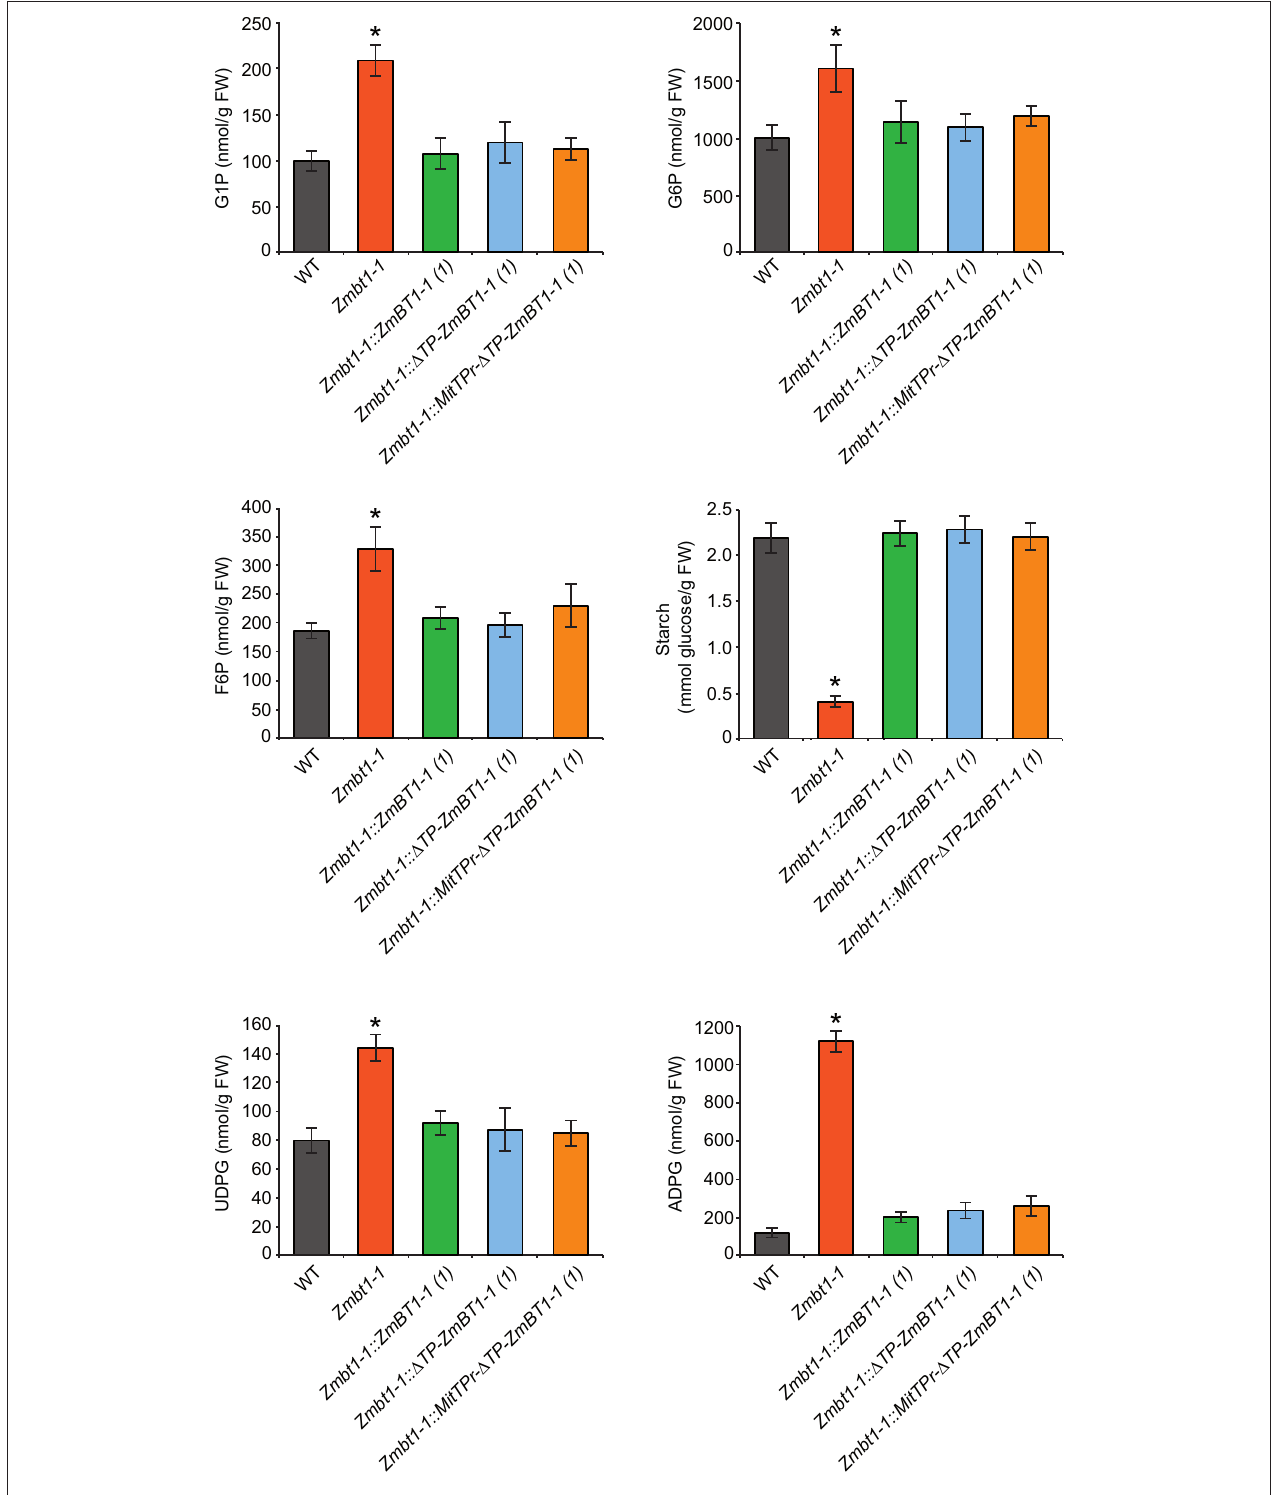
FIGURE 3 | Delivery of ZmBT1-1 specifically to mitochondria reverts to WT the content of ADPglucose and other sucrose-to-starch biosynthetic intermediates in developing Zmbt1-1 endosperms. The graphics represent the amounts of the metabolites indicated in 24 DAP endosperms from WT, Zmbt1-1, Zmbt1-1::ZmBT1-1(1), Zmbt1-1:: 1 TP-ZmBT1-1(1), and Zmbt1-1::MitTPr- 1 TP-ZmBT1-1(1) seeds. Values represent the mean ± SD of determinations on four independent samples. Asterisks indicate significant differences based on Student’s t -tests. ( P < 0.05, Zmbt1-1 mutants vs. WT).